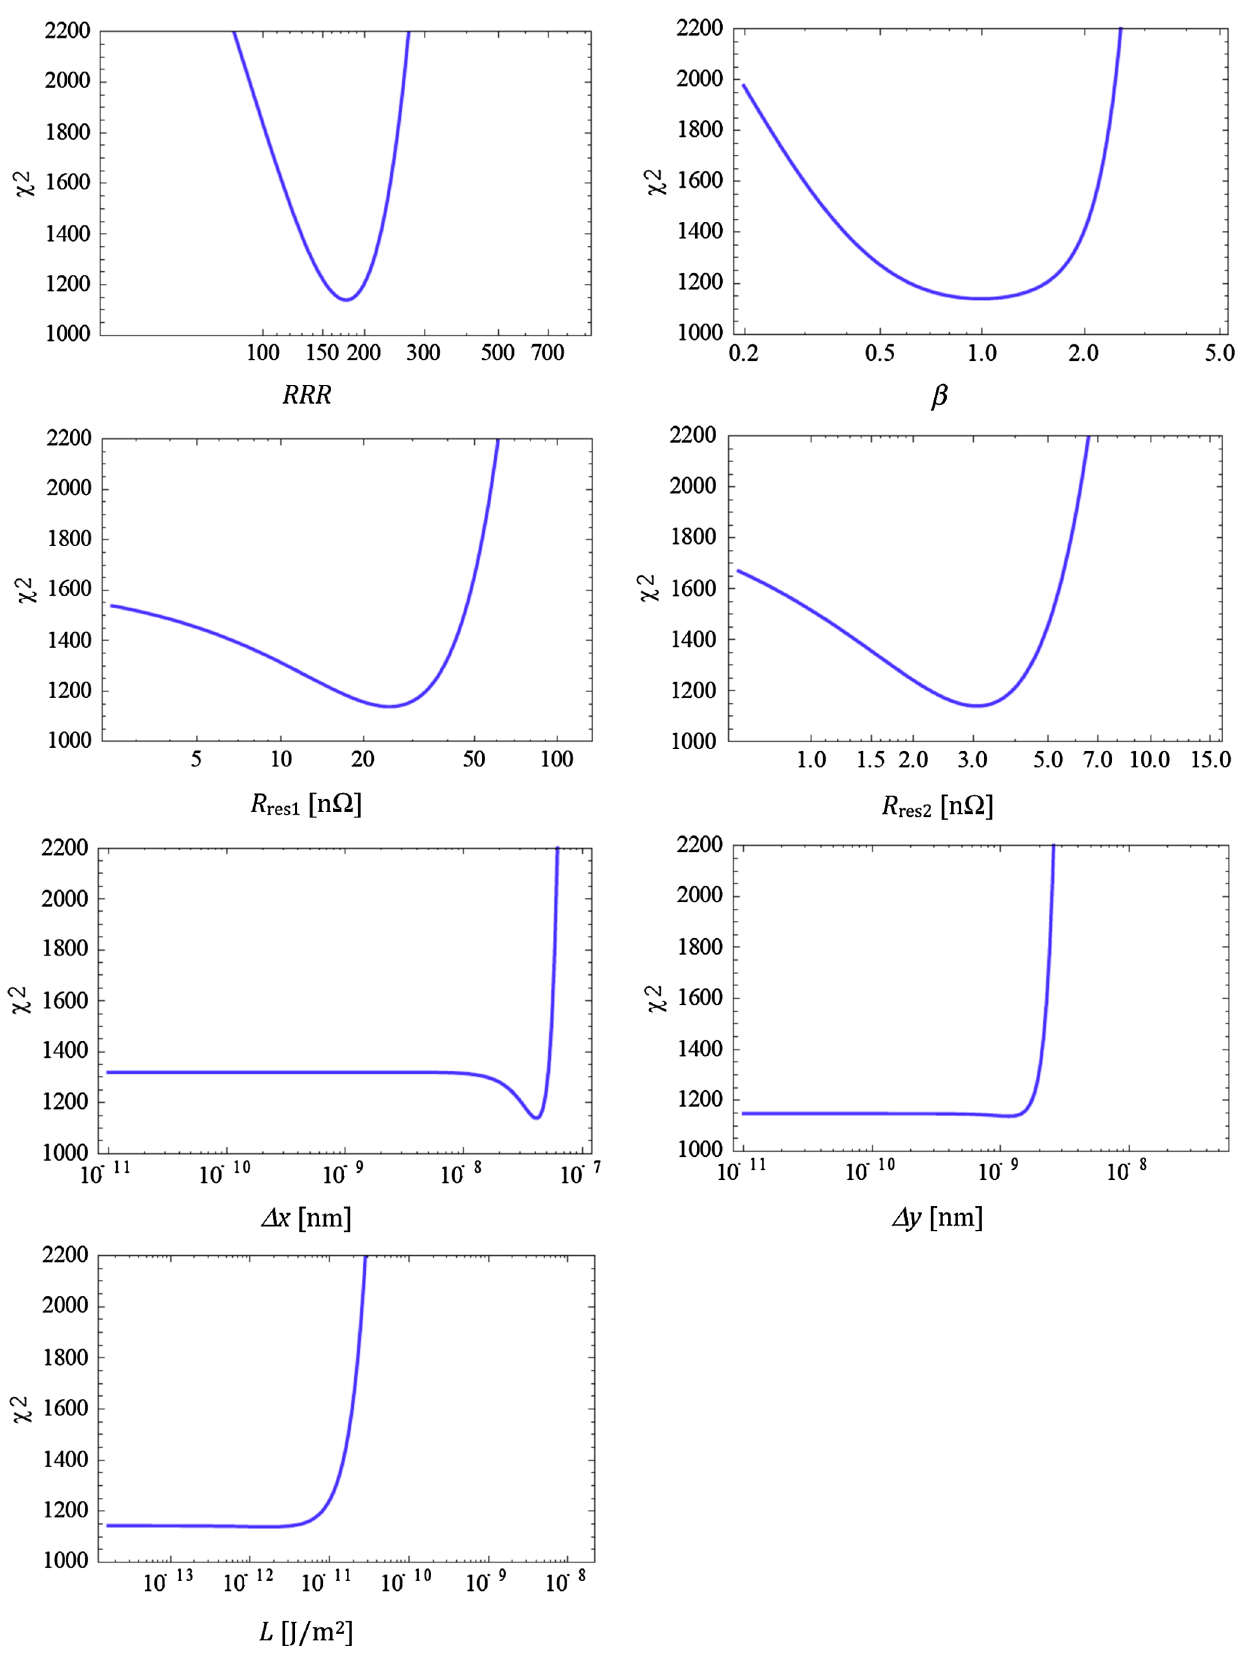
FIG. 9. Results of the (cid:6) 2 minimization of the fit parameters related to the surface resistance R s .